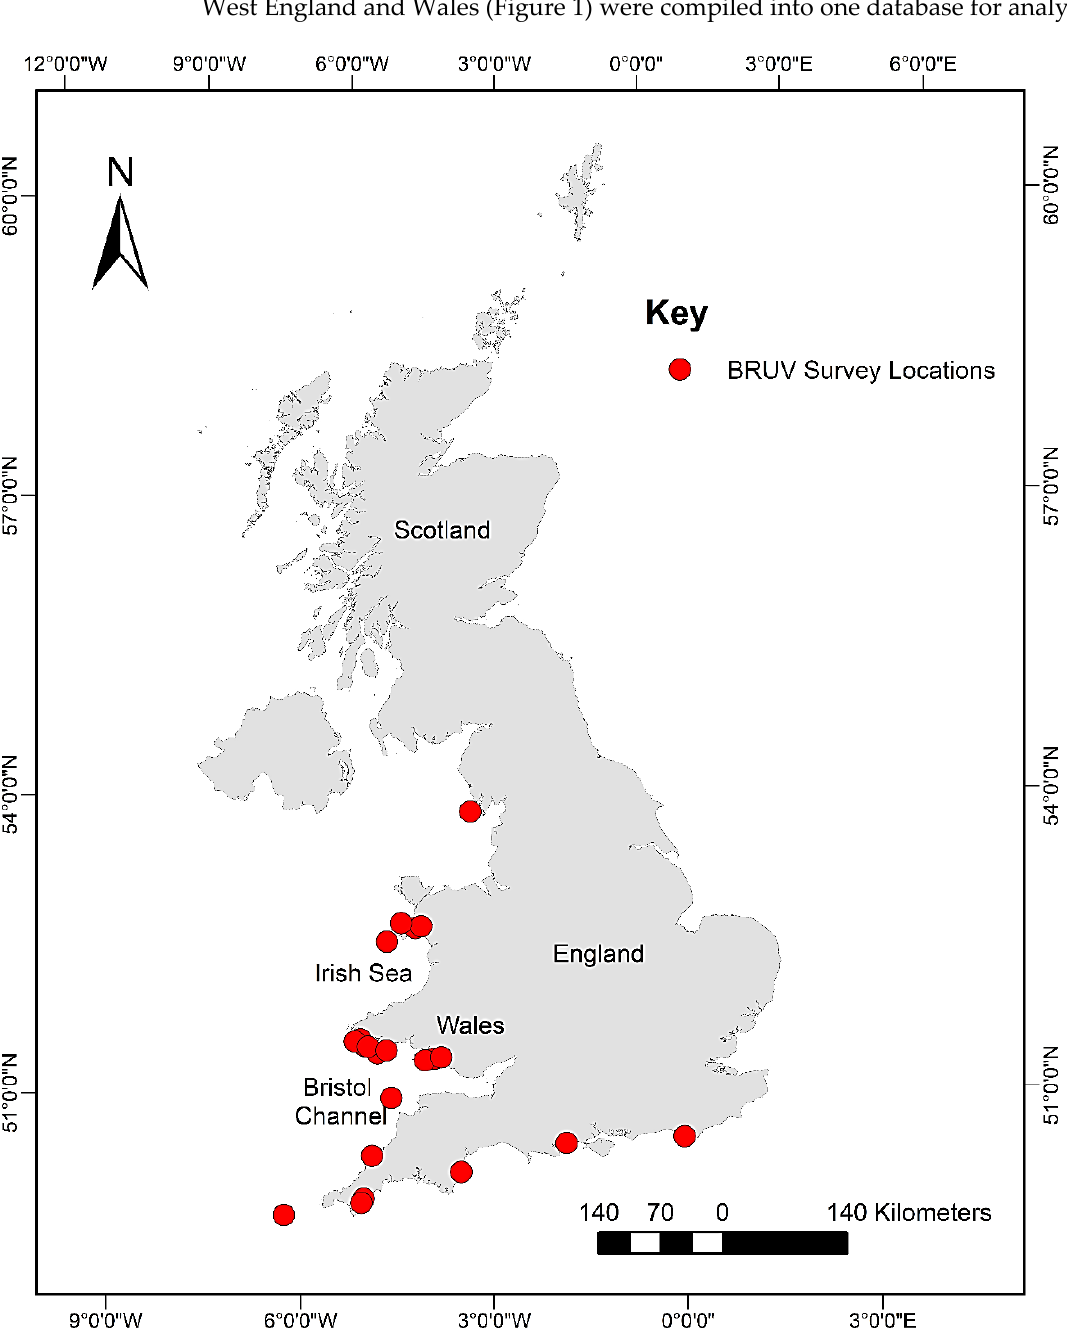
Figure 1. Map showing the locations of the BRUV surveys which form the database used in this